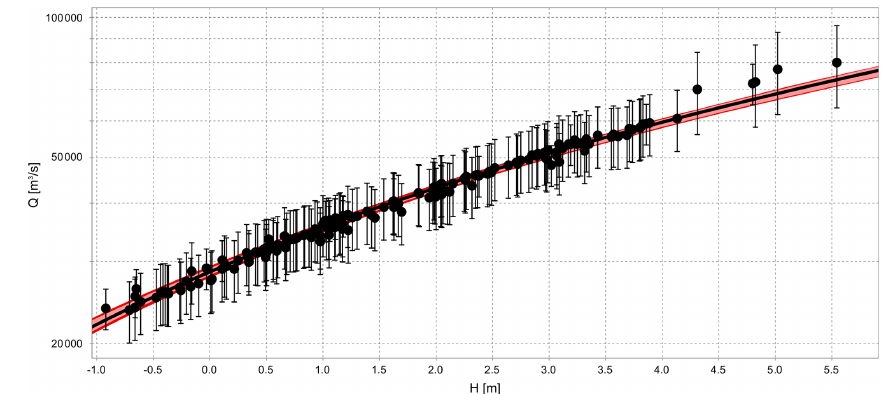
Figure 3. Jaugeages avec incertitudes du Congo à Brazzaville et courbe de tarage avec incertitudes obtenue par la méthode BaRatin.